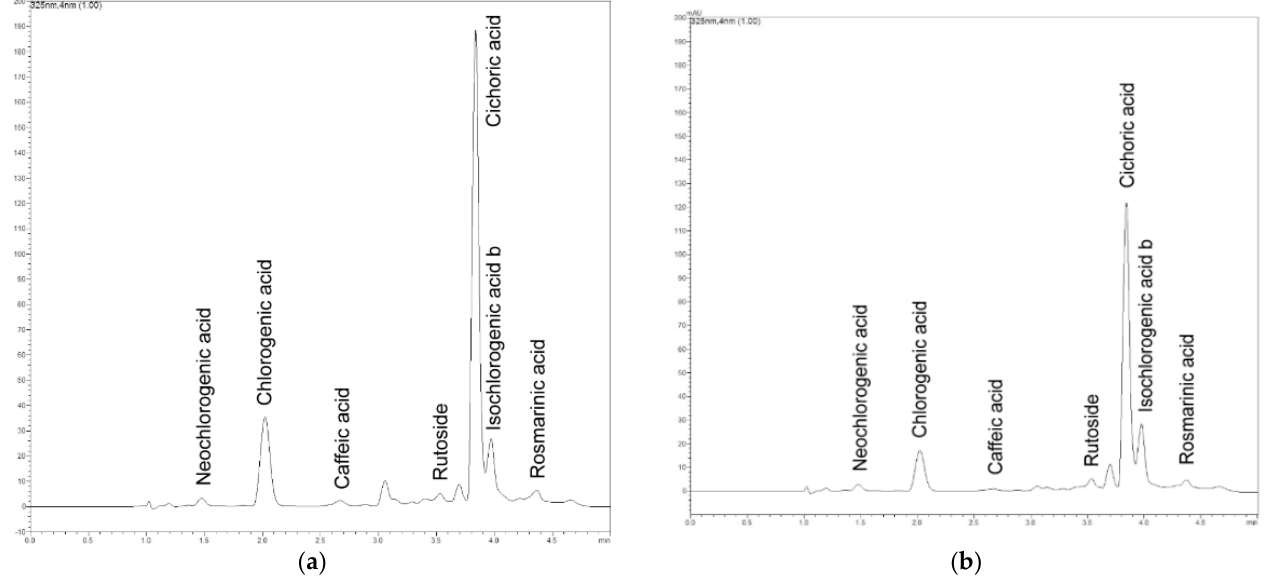
Figure 1. Chromatograms of H. italicum herb ( a ) and inflorescences ( b ) methanolic extracts.